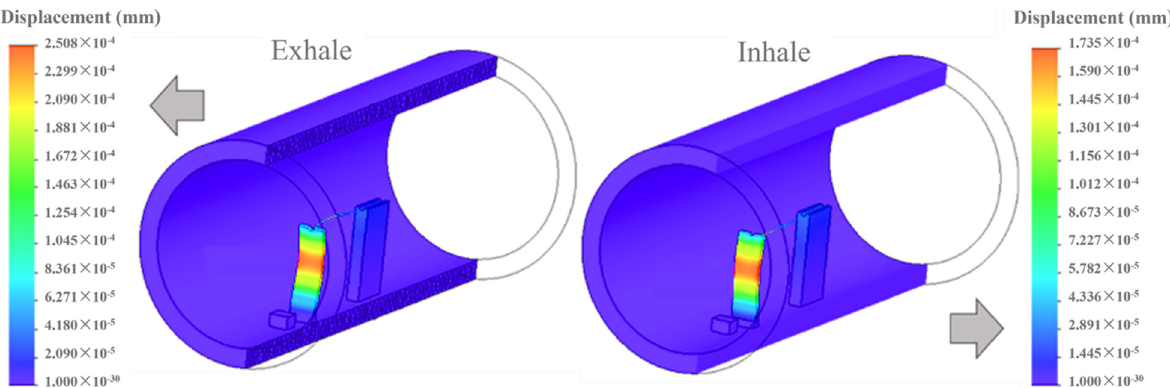
Figure 5. Expected effect of an air flow of 6 L/s on the proposed spirometer, for the exhale and inhale moments.